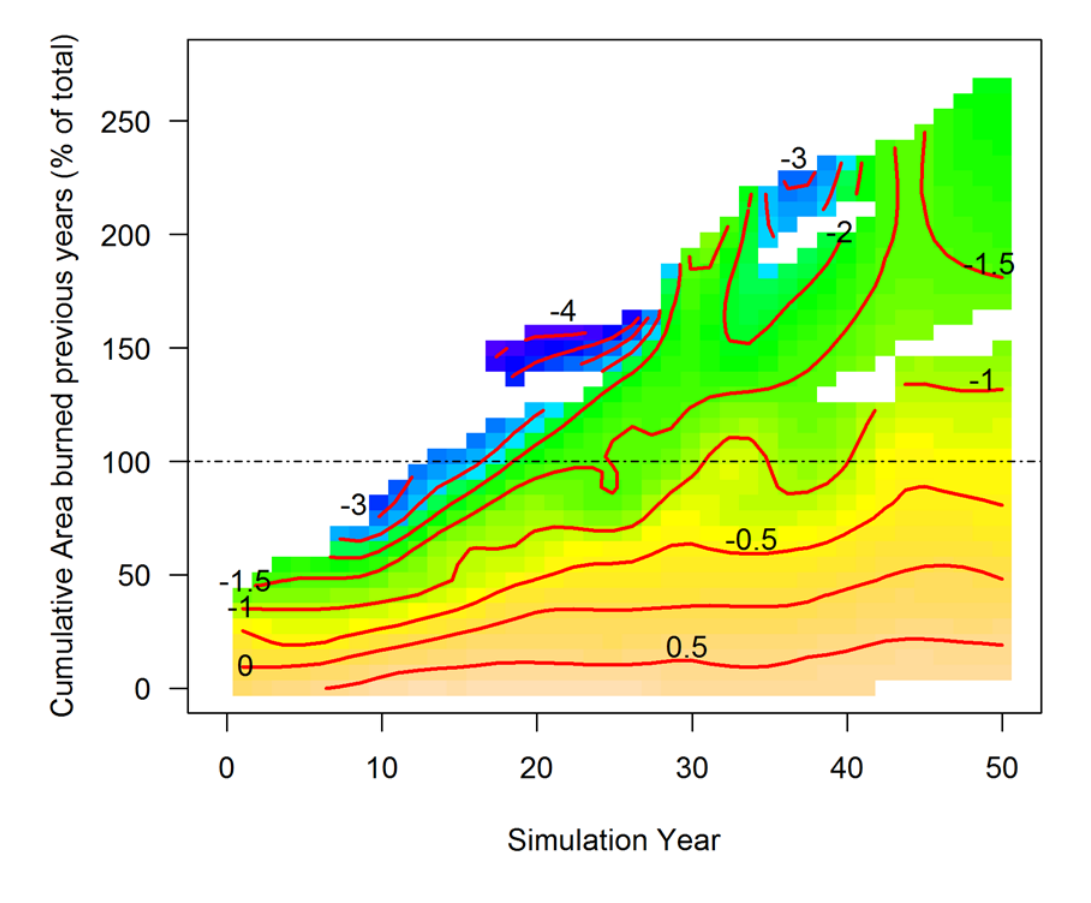
Fig. A3.1. Contour plot of change in average rate of spread (m min -1 ) relative to the mean rate of spread as a function of simulation year and percentage of study area previously burned. The dashed line indicates the level at which an area equivalent to the whole study area (100%) was burned in previous years. Contour = 0 represents no change relative to average rate of